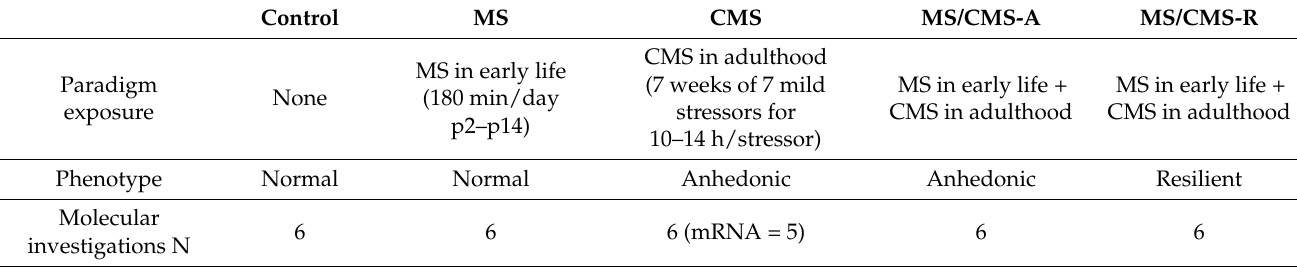
Table 1. Experimental groups and conditions. MS, maternal separation, CMS, chronic mild stress, MS/CMS-A: animals exposed to both CMS and MS, exhibiting anhedonia MS/CMS-R, resilient animals exposed to both CMS and MS. Control